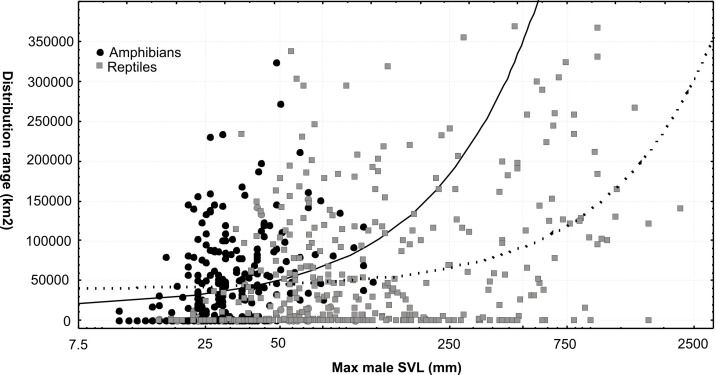
Body size and range sizes correlations.Correlation of body size with range size in amphibians (black circles and solid line) and reptiles (white squares and dashed line). Both correlations are highly significant (see text).